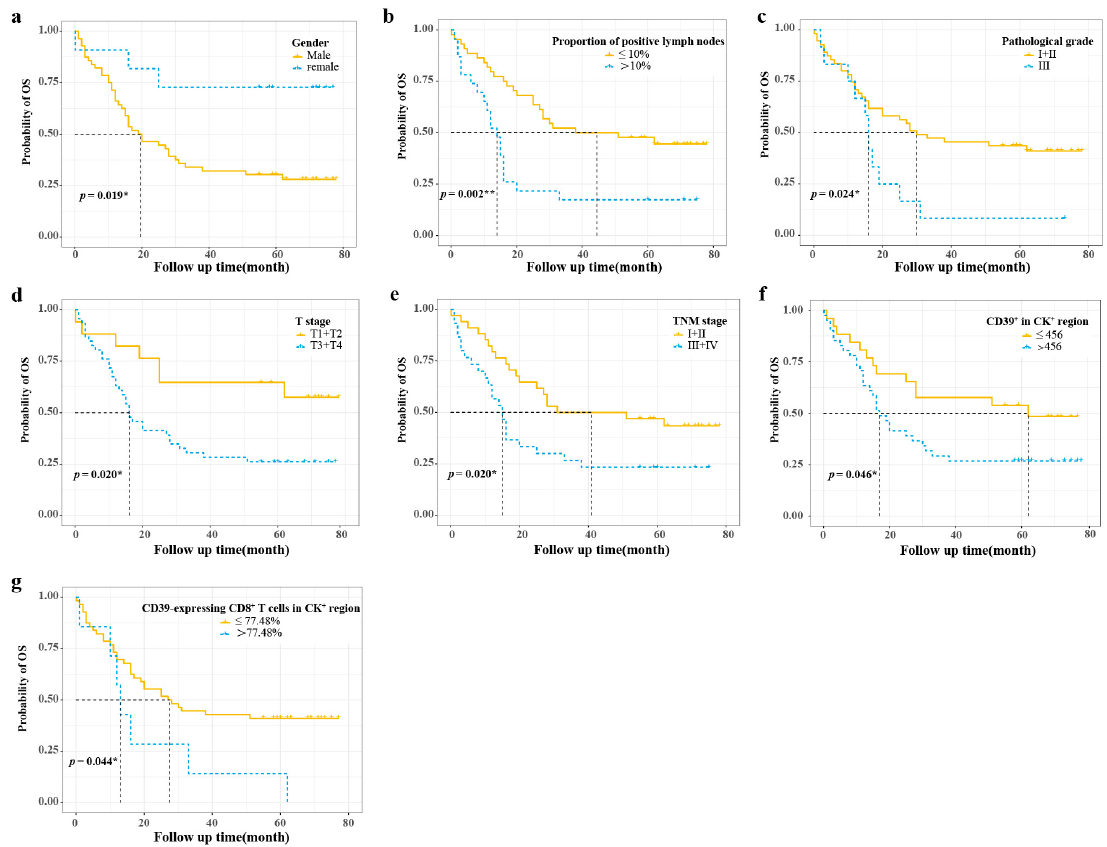
Figure 2. Survival curve analysis of prognostic variables with statistically significant differences. ( a – d ) Survival curve analyses of gender, proportion of positive lymph nodes, pathological grade, and T stage; ( e – g ) Survival curve analyses of TNM stage, CD39 + in CK + region, and CD39-expressing CD8 + T cells in CK + region. CD39, ectonucleoside triphosphate diphosphohydrolase 1; CK, cytokeratin; OS, overall survival. * p < 0.05, ** p < 0.01. Table 2. Univariate and multivariate Cox regression analysis of 67 ESCC patients.